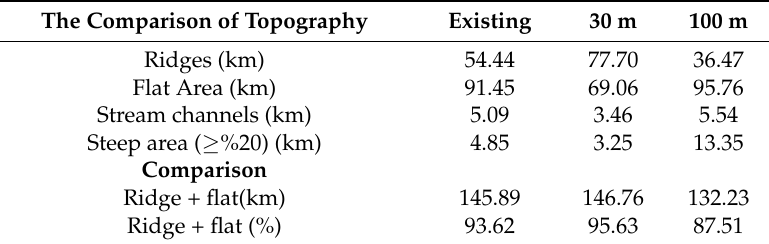
Table 4. The comparison of topography.